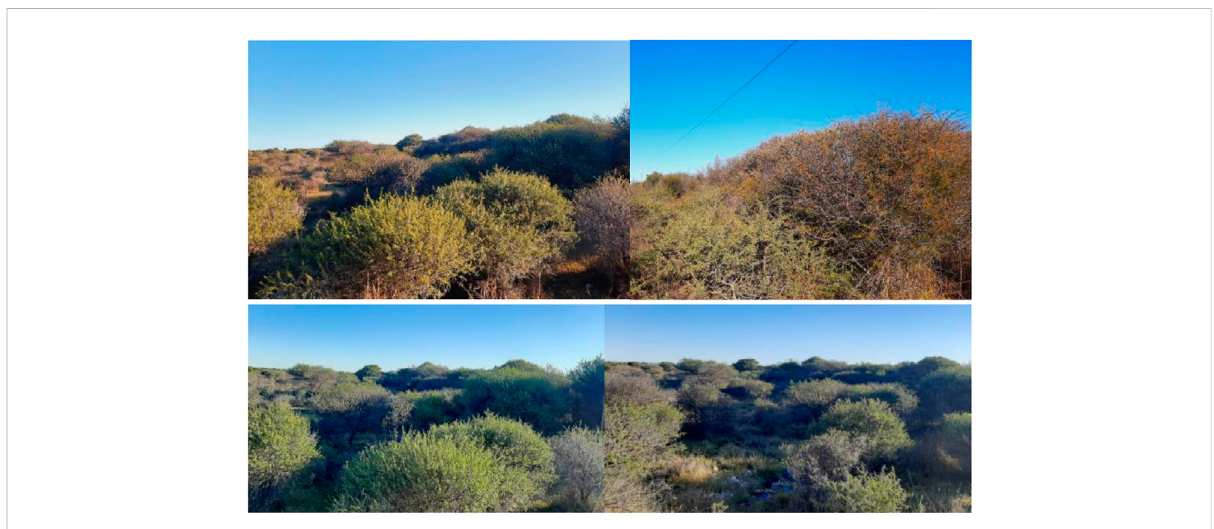
FIGURE 2 Bush encroachment, spread of acacia species around North West province of South Africa. Photo taken by H. S. and K.